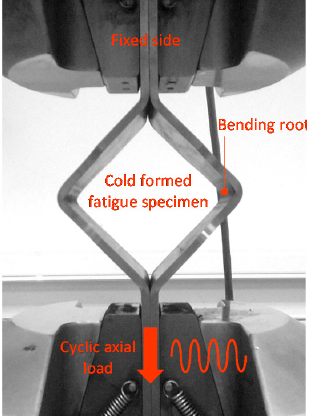
Figure 1. Fatigue test set-up of cold formed specimen after 90° bending with a bending ratio r / t = 3.